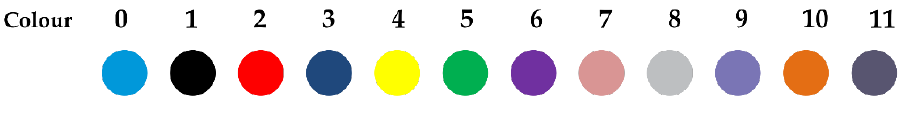
Figure 10. Color spectrum of the L(3,1) algorithm.